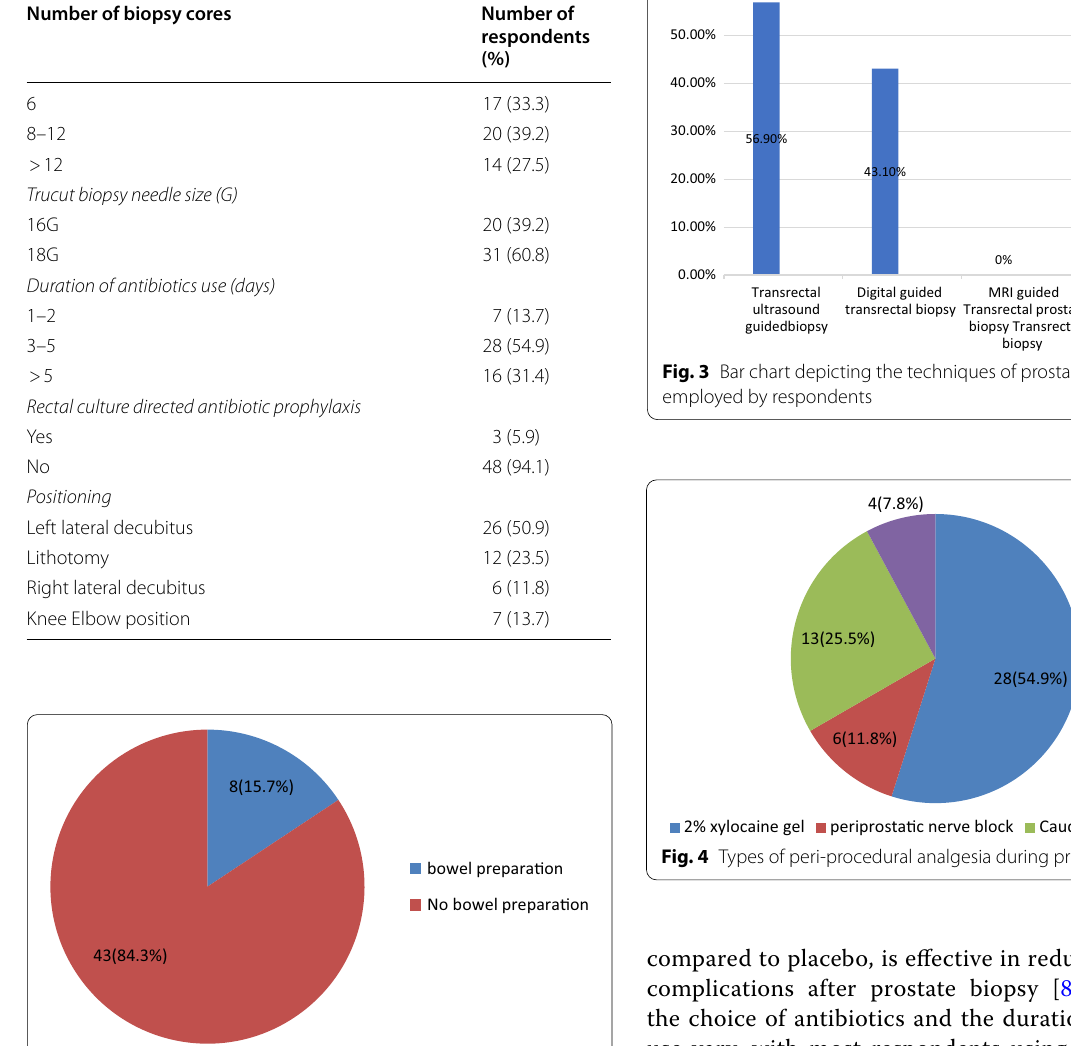
Fig. 2 Pie Chart showing the use or otherwise of bowel preparation prior to prostate biopsy